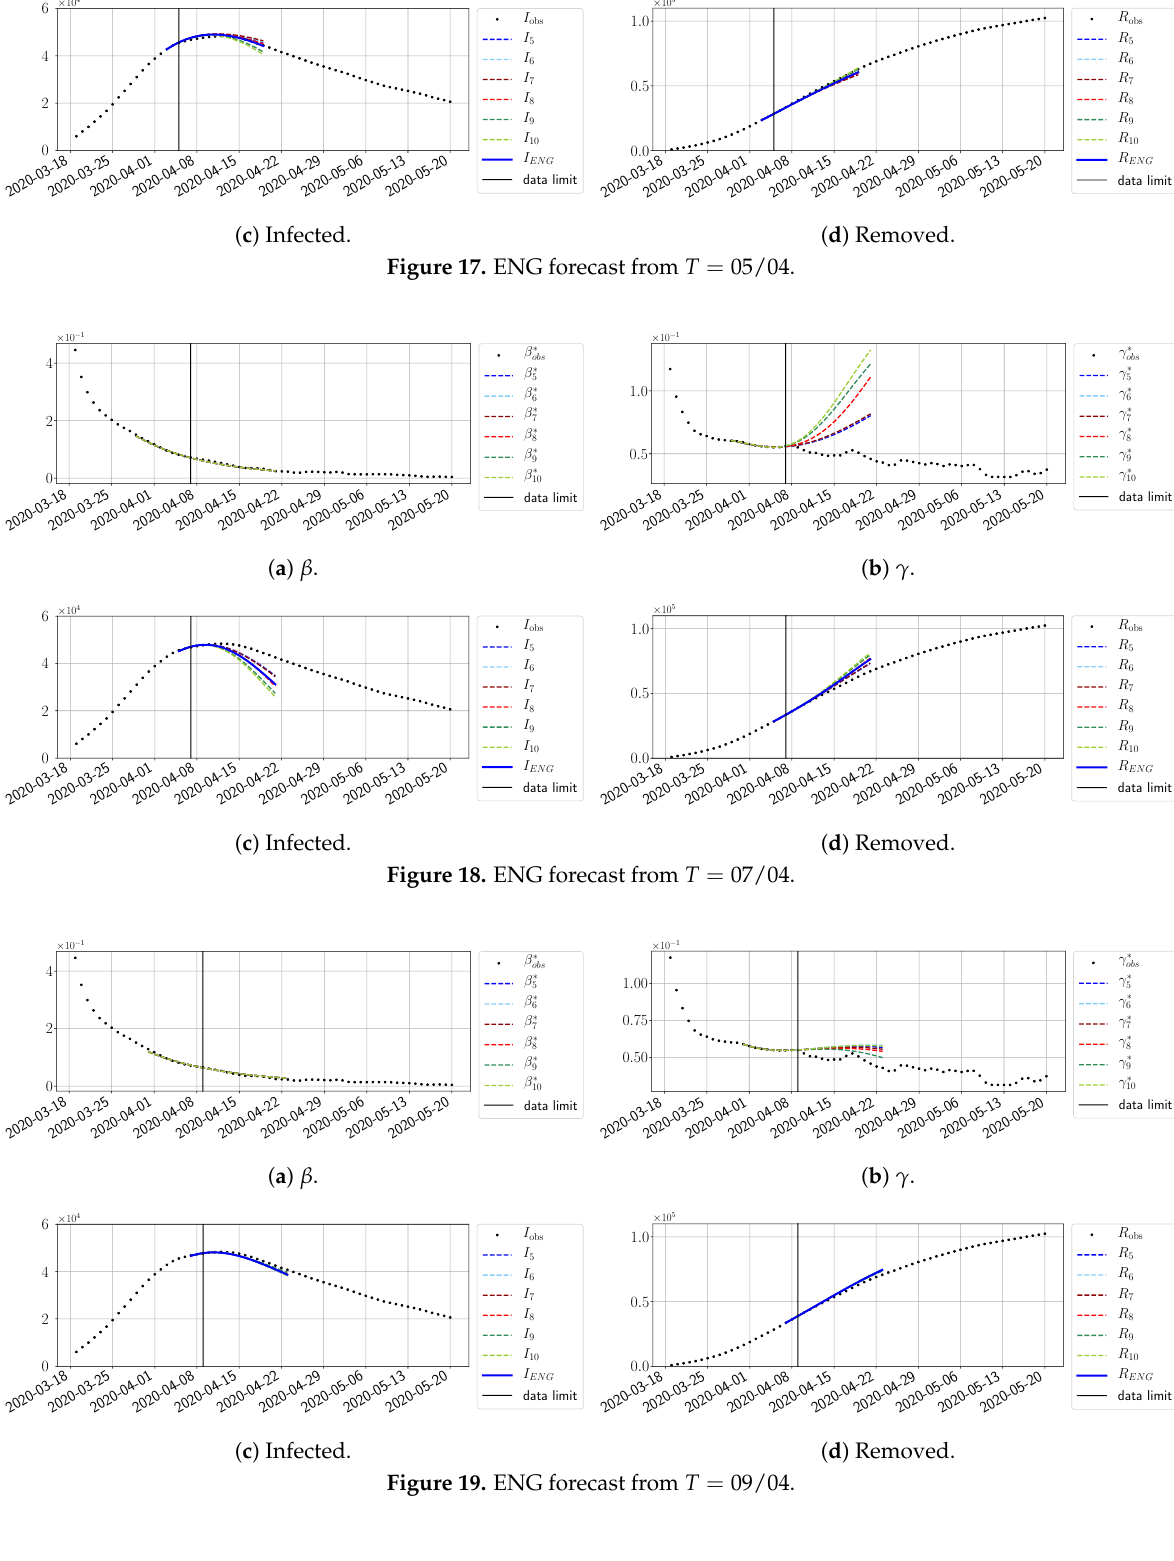
Figure 19. ENG forecast from T =